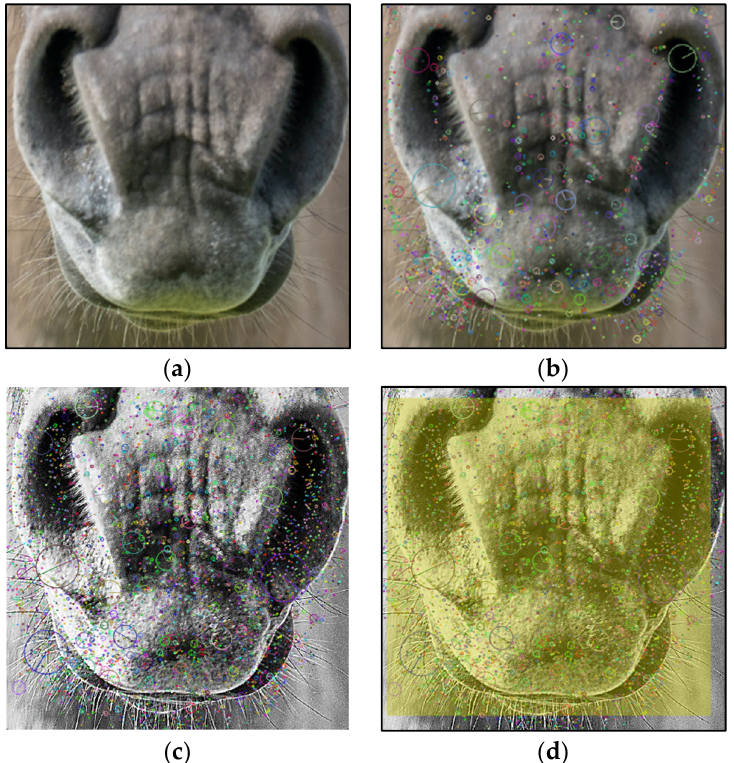
Figure 8. ( a ) Originally detected muzzle image of a horse far away from the camera, ( b ) a grayscale image with some keypoints detected by SIFT before processing, ( c ) unique, descriptive features detected by SIFT after processing, and ( d ) region of interest highlighted, where unique keypoints are detected.